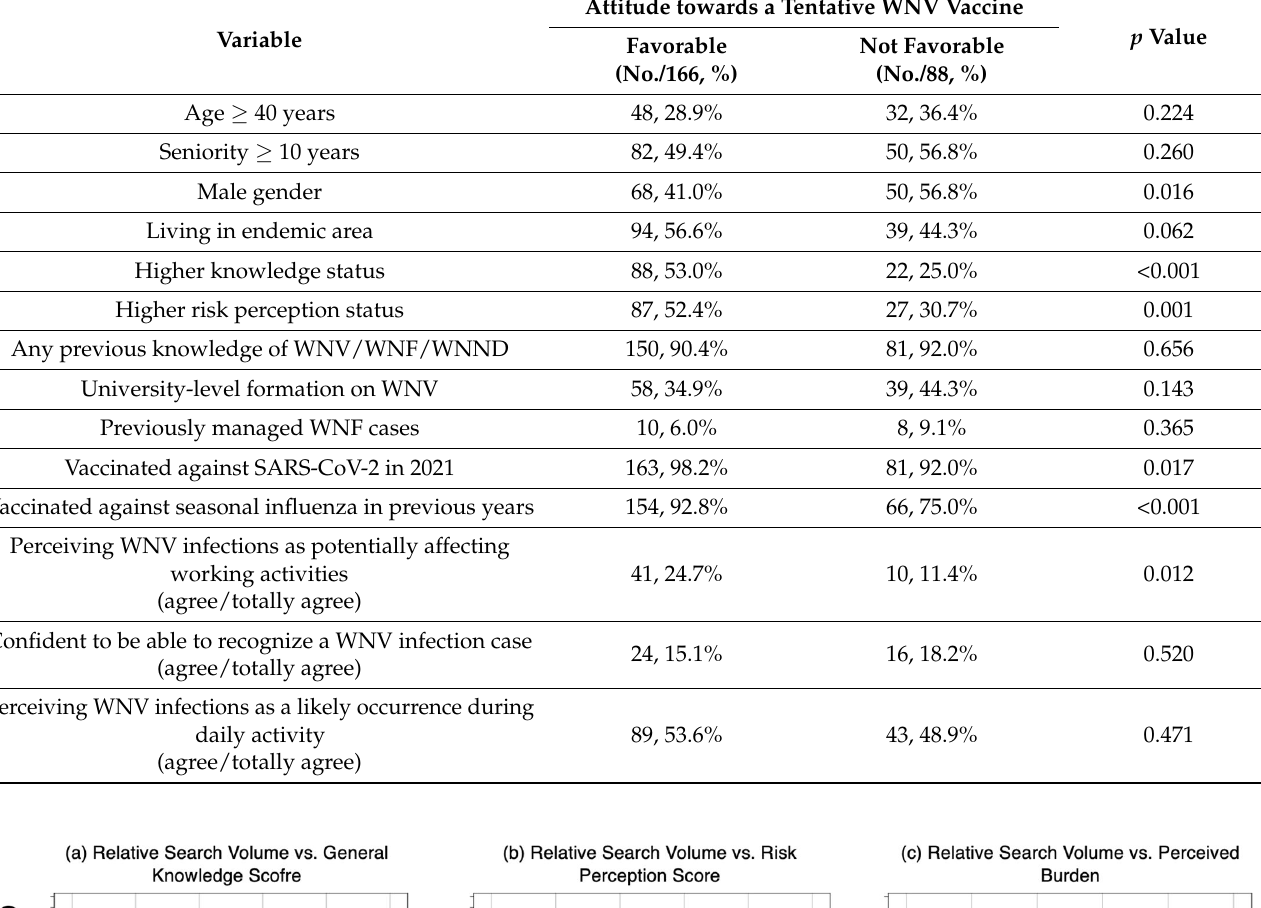
Table A3. Characteristics of the 254 Italian medical professionals participating into the survey on knowledge, attitudes, and practices on West Nile Virus (WNV) by being or not being favorable on receiving a tentative WNV vaccine.